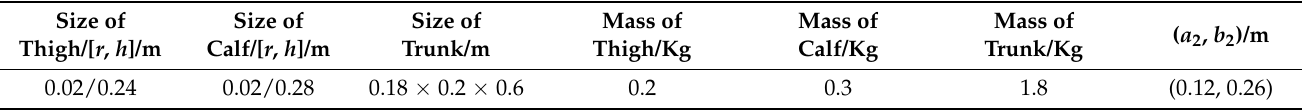
Table 1. Structural parameters of the cheetah-inspired quadruped